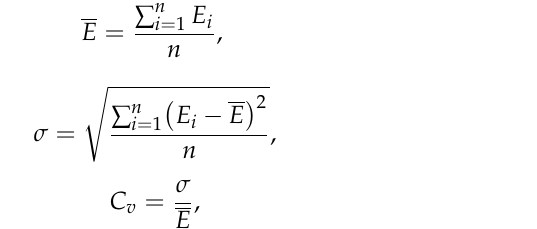
Table 3. Average illuminance standard for road grades [18,38].